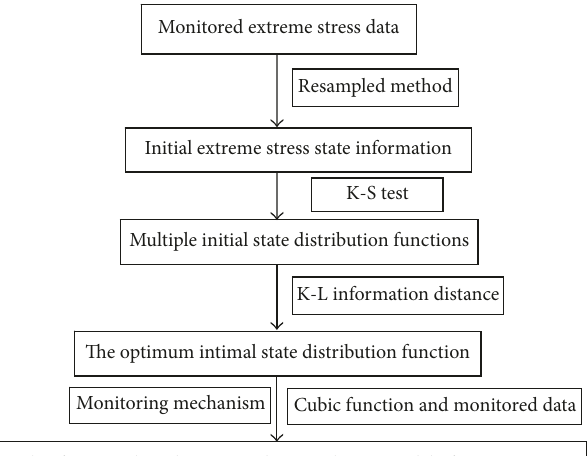
Figure 1: The building processes of the optimum Bayesian dynamic linear